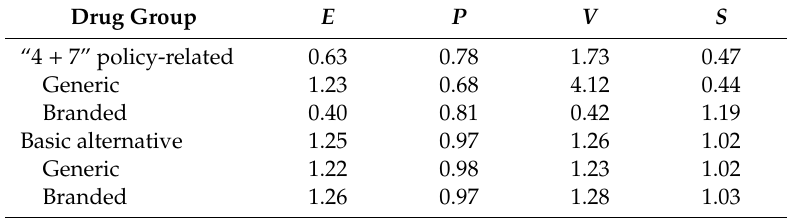
Table 4. Results of decomposition analysis for generic products and branded products. Drug Group E